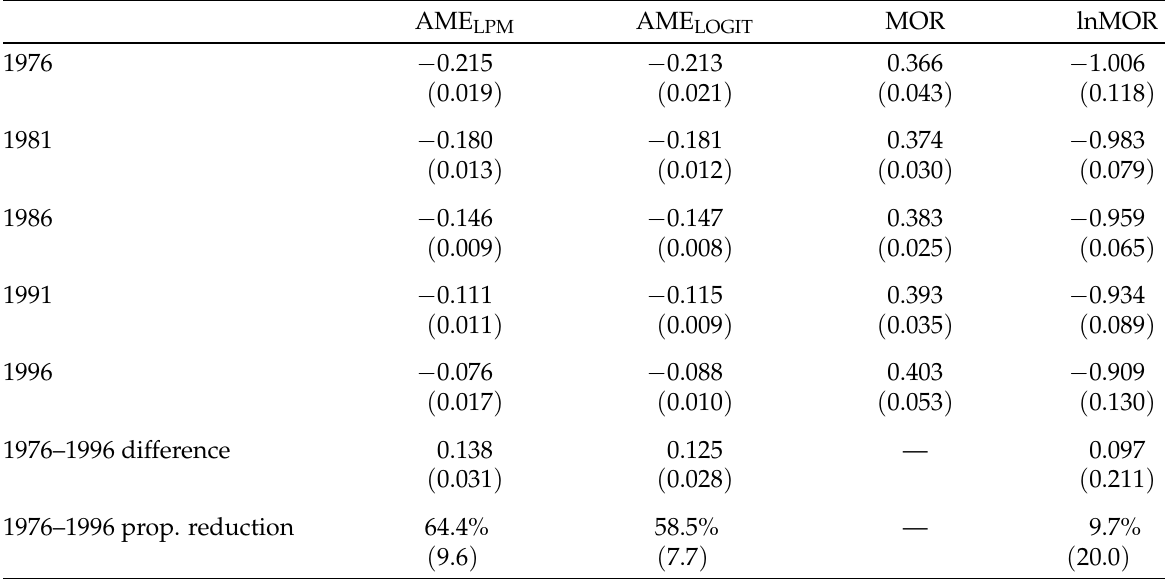
Table 2: Average marginal effects and marginal odds ratios of the college gap in the attitude toward racial segregation in 1976, 1981, 1986, 1991, and